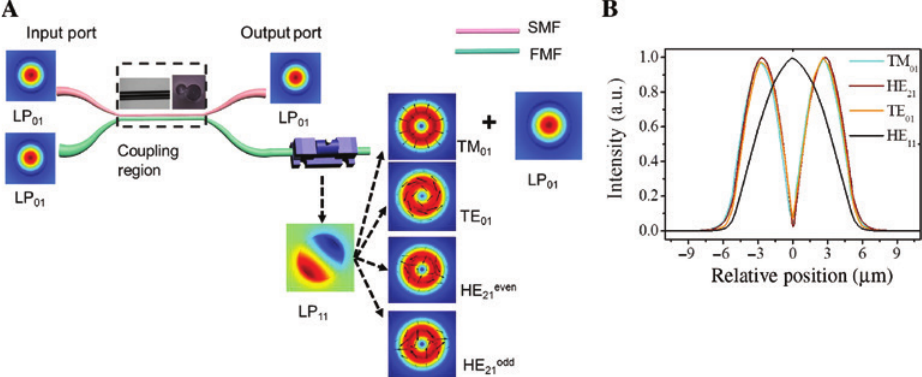
Figure 1: The structure and vector modes profiles of mode selective coupler. (A) The schematic of the mode selective coupler. Inset: the top- and cross-sectional pictures of the coupling region. (B) Intensity profiles of vector modes in few-mode fiber based on numerical